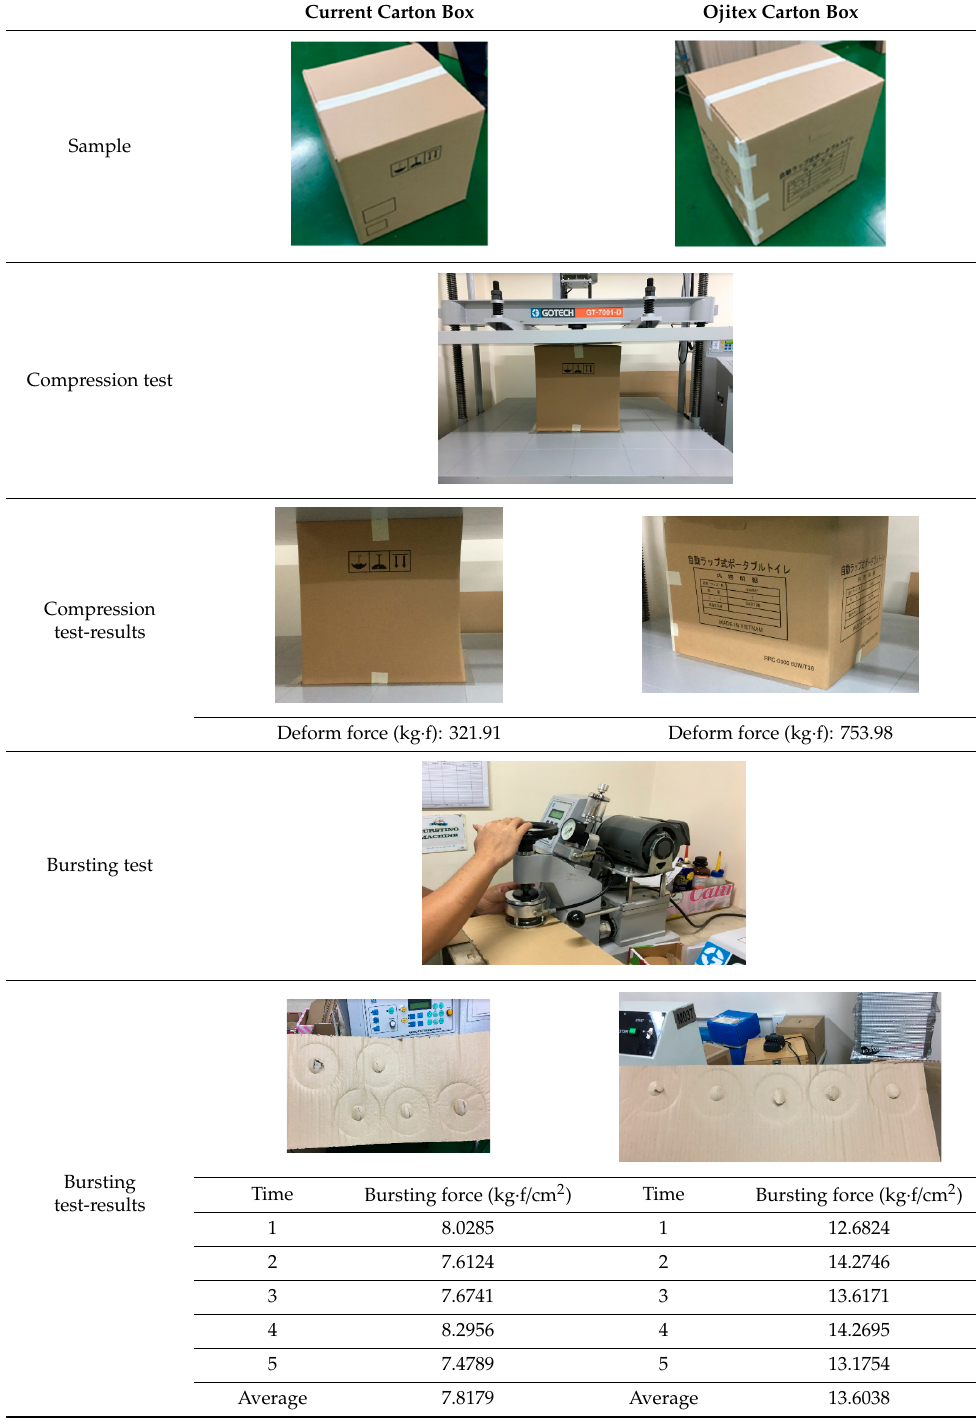
Table 5. Carton box testing.